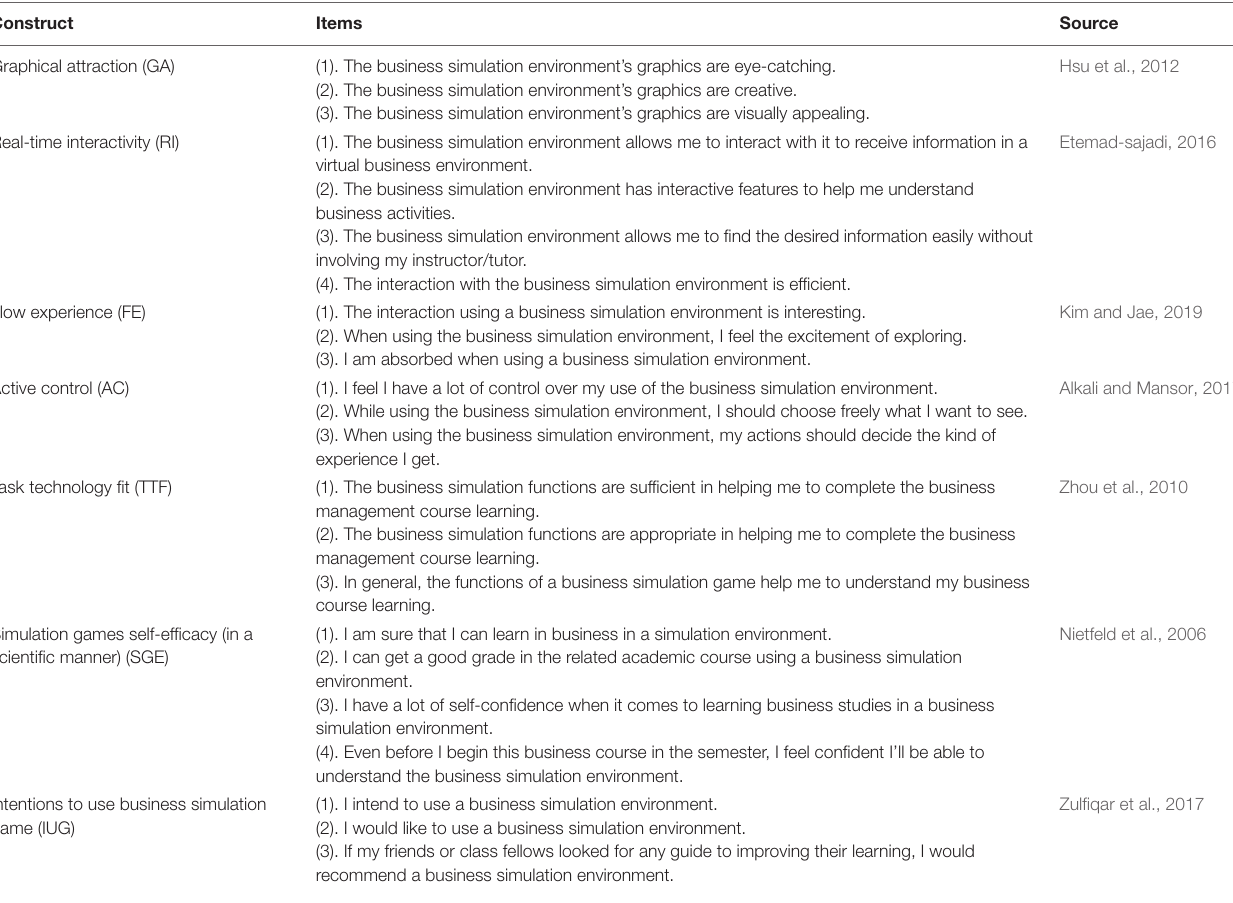
TABLE 1 | Adapted instrument with listed